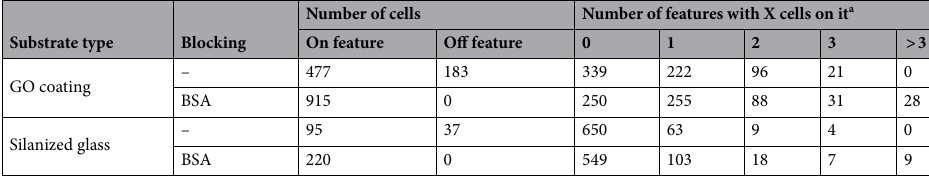
Table 1. Cell adhesion on protein microarrays. Quantification of the number of cells adhered onto GO coating versus the silanized glass substrates with and without prior BSA blocking. a Sum of features in the table does not match up to the total features in an array, as of exclusion of the cell-bridged features (see supporting information Fig. S3 for